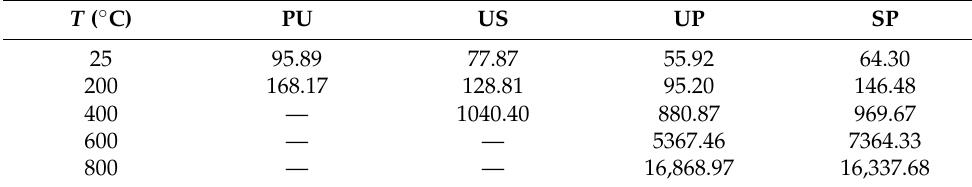
Figure 9. Capillary water absorption curves after exposure to high temperatures. Table 4. Initial capillary water absorption coefficients after exposure to high temperatures.